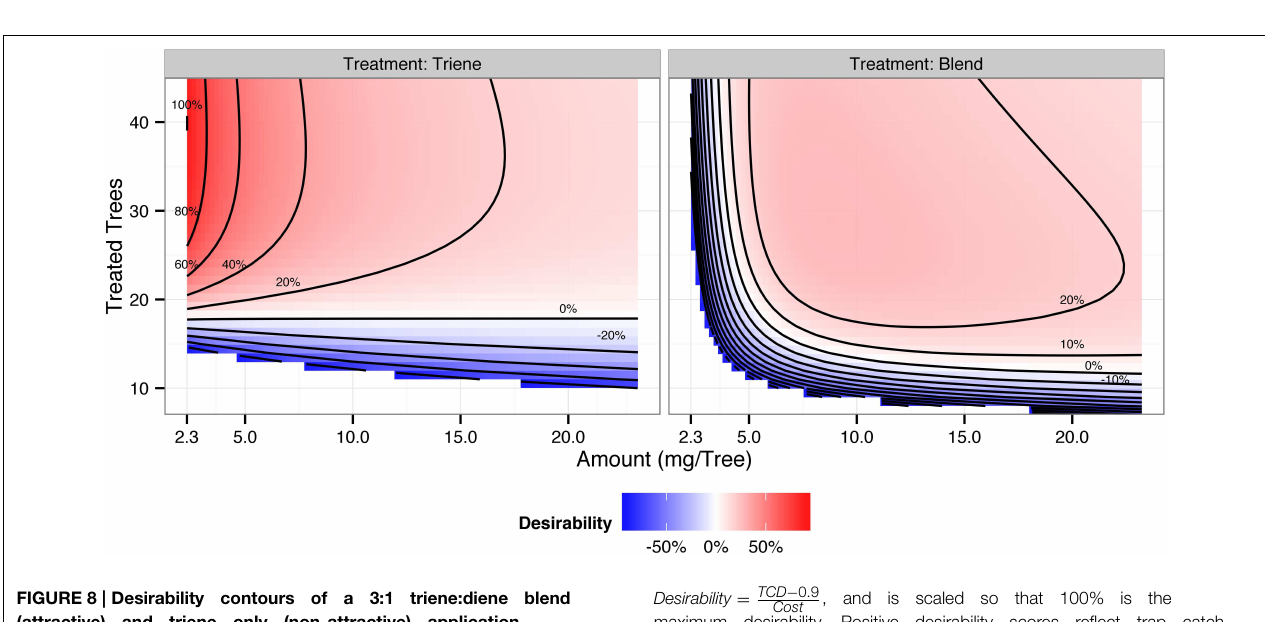
Desirability = TCD − 0 . 9 Cost , and is scaled so that 100% is the maximum desirability. Positive desirability scores reflect trap catch disruption above 90%; negative desirability scores reflect trap catch disruption below